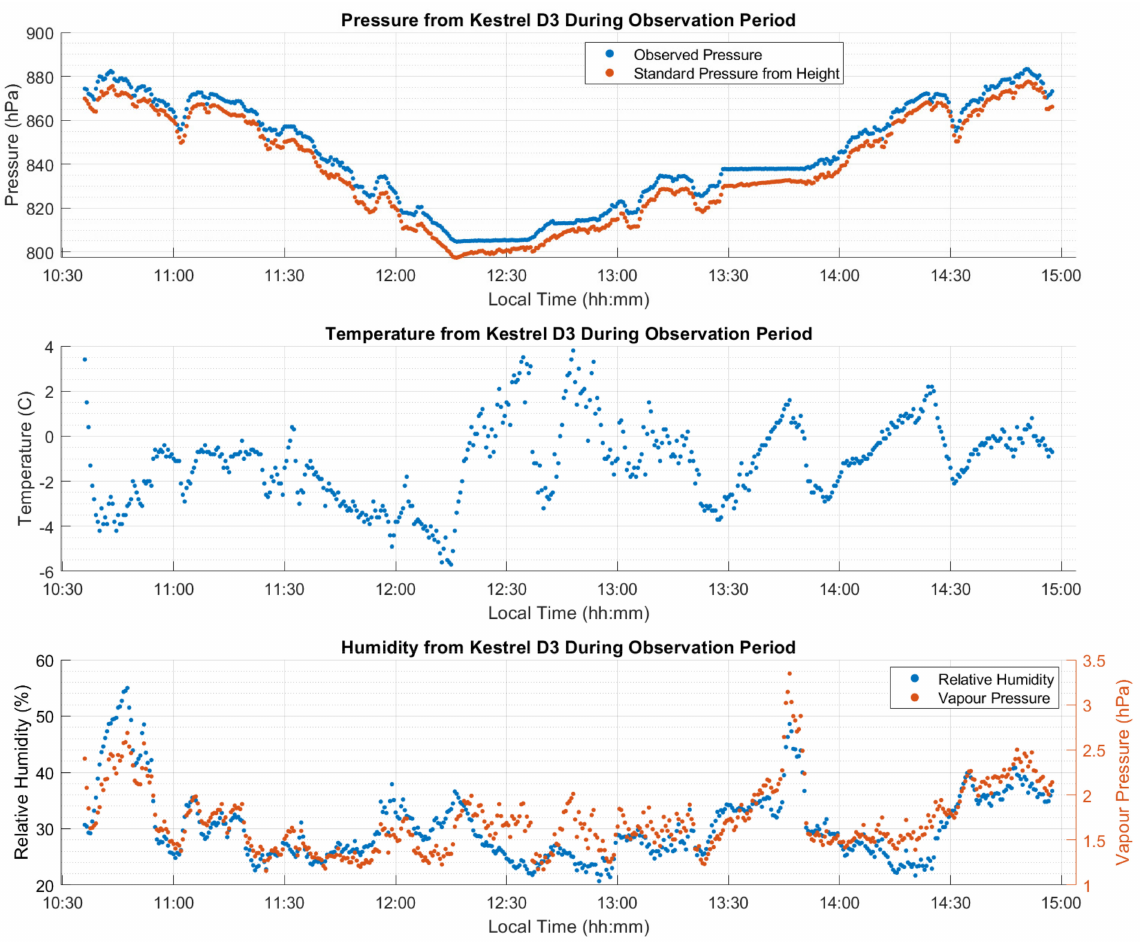
Figure 21. Kinematic dataset C atmospheric measurements made on the vehicle during the test. Measured atmospheric pressure was 3 to 9 hPa higher than standard values. Water vapour spiked at 13:30 local time due to a brief snowfall. Local time is UTC −